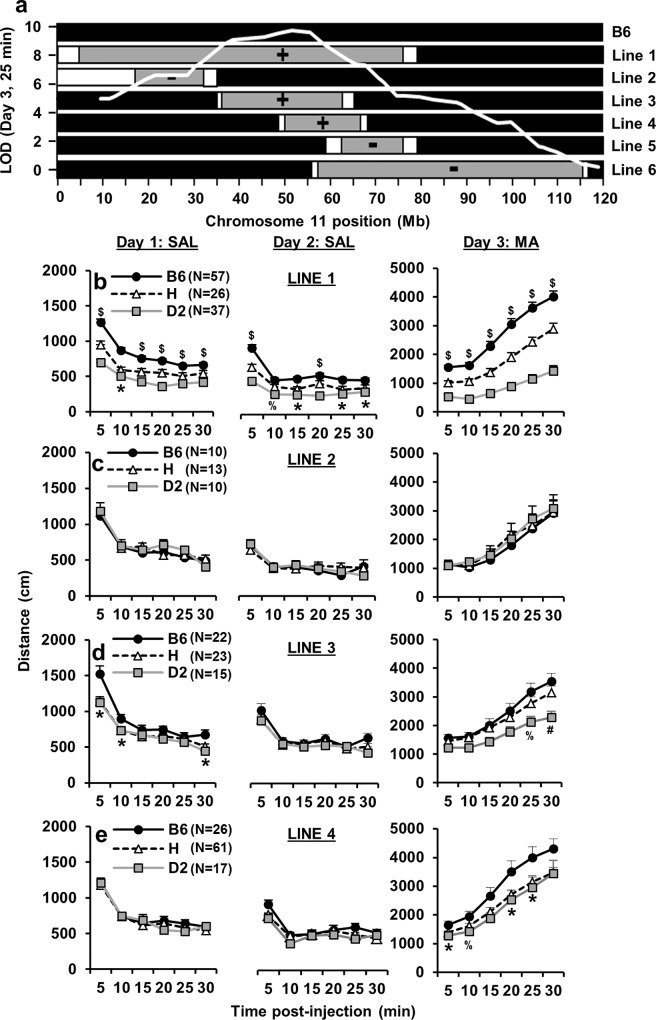
Congenic analysis identifies Line 4 for fine mapping.Statistical results are provided in S3 Table and described in the Supplementary Information. (a): Lines 1–6 possessed either one (heterozygous; “H”) or two copies (homozygous, “D2”) of a chromosome 11 interval from the D2 inbred strain (gray region) on an isogenic B6 background (black region; denotes the genotype for the rest of the genome). The white regions represent transitional regions that were not genotyped. The x-axis represents the physical position (Mb) of the SNP marker. The SNP markers that were used to genotype Lines 1–6 are listed in S1 Table. The y-axis represents the LOD score for the F2-derived QTL that was causally associated with reduced MA sensitivity on Day 3 (D2 < B6; Fig 1; 25 min bin). (+) = congenic line captured the QTL for reduced MA sensitivity on Day 3. (-) = congenic line failed to capture the QTL. (b-e): The three columns represent the phenotypes for Days 1, 2, and 3. The four rows represent Lines 1–4. The negative results for Lines 5 and 6 (-) are shown in S2 Fig and described in S1 Text. “*” indicates a dominant effect of the D2 allele (D2 = H < B6) or H < B6. “$” indicates an additive effect (D2 < H < B6). “#” indicates a recessive effect (D2 < H = B6). “%” indicates that B6 and D2 differ from each other but not from H. “&” indicates that H and D2 differ from each other but not from B6. Data are represented as the mean ± S.E.M. p < 0.05 was considered significant. We estimated the narrow-sense heritability of the QTLs (h2) for Line 3 and Line 4 (25 min) based on the intraclass correlation coefficient using the phenotypic variances from homozygous D2 versus homozygous B6 mice according to the following formula: h2 = (between-genotype variance) / (between-genotype variance + within-genotype variance). For Line 3, h2 = 0.35; for Line 4, h2 = 0.08. Although these h2 estimates do not contain confidence intervals, the differences in h2 values combined with the different modes of inheritance suggest that Line 3 and Line 4 possess different QTLs.